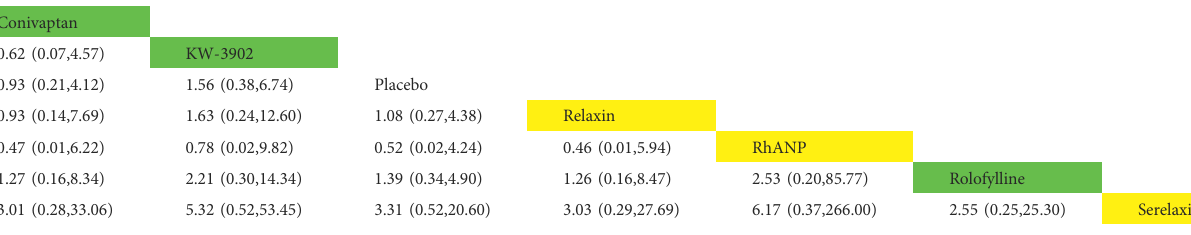
Comparison of the consistency model and the inconsistency model results showed that they were in good agreement (0.49 vs. 0.48). Similar to the rates of adverse events, there was no statistical difference between the effects of drugs on patients were involved.